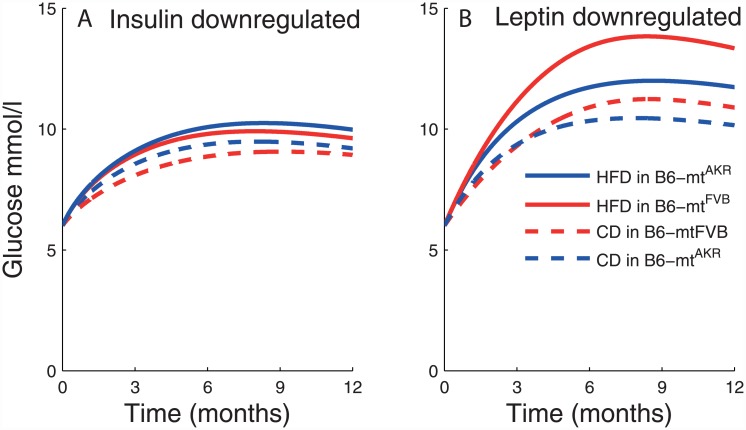
Redundancy of insulin and leptin pathways allows more effective adaptation of blood glucose response with age.Redundancy of insulin pathway and leptin pathway was removed by alternately downregulating the insulin and leptin derivatives to zero. The blood glucose levels remained elevated at the later age, indicating compromised adaptation, in all cases for both insulin downregulation (A) and leptin downregulation (B).